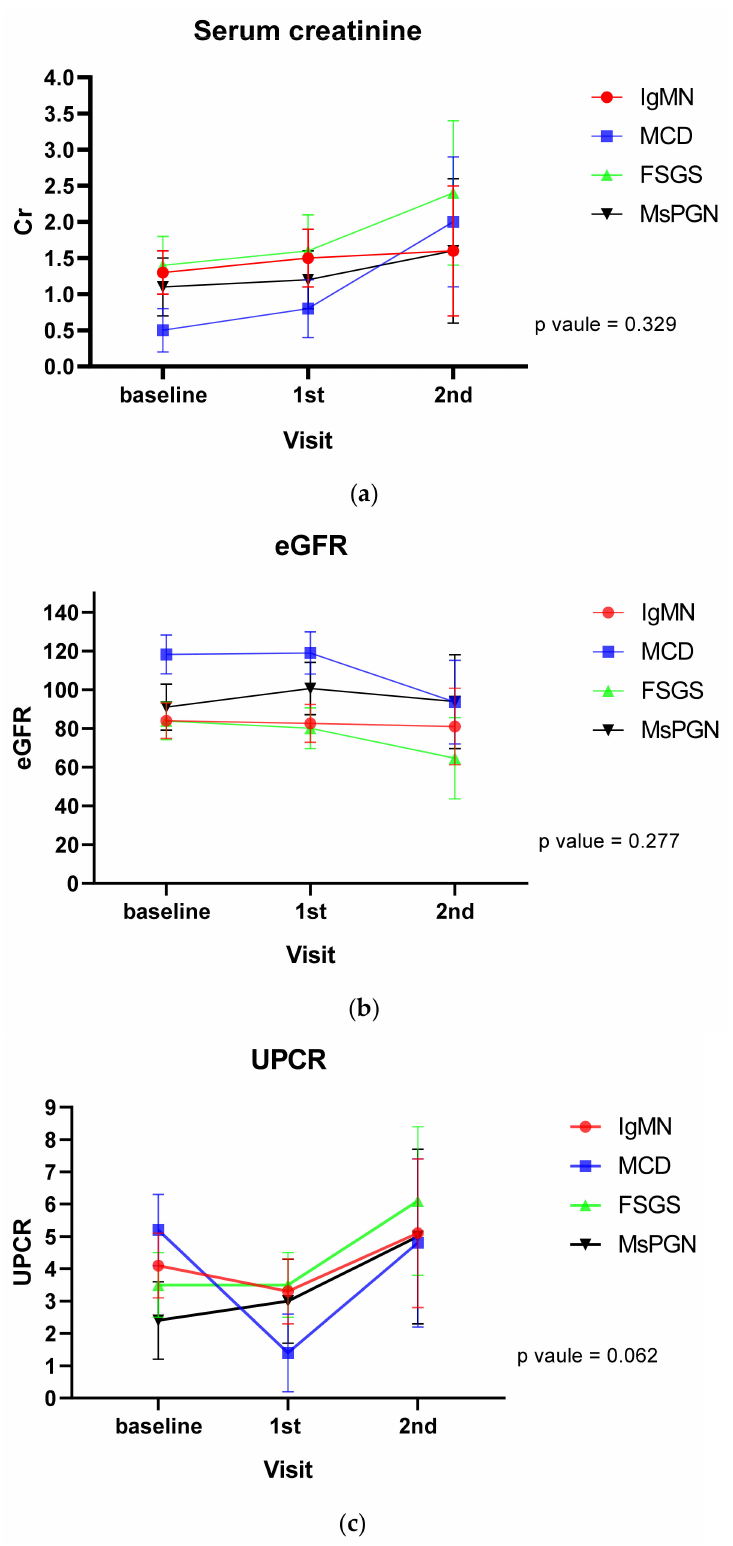
Figure 2. Time course of serum creatinine ( a ), eGFR ( b ), and proteinuria ( c ) corrected by confusion variables. Cr, creatinine; eGFR, estimated glomerular filtration rate. The p value reflects both the time effect and the group